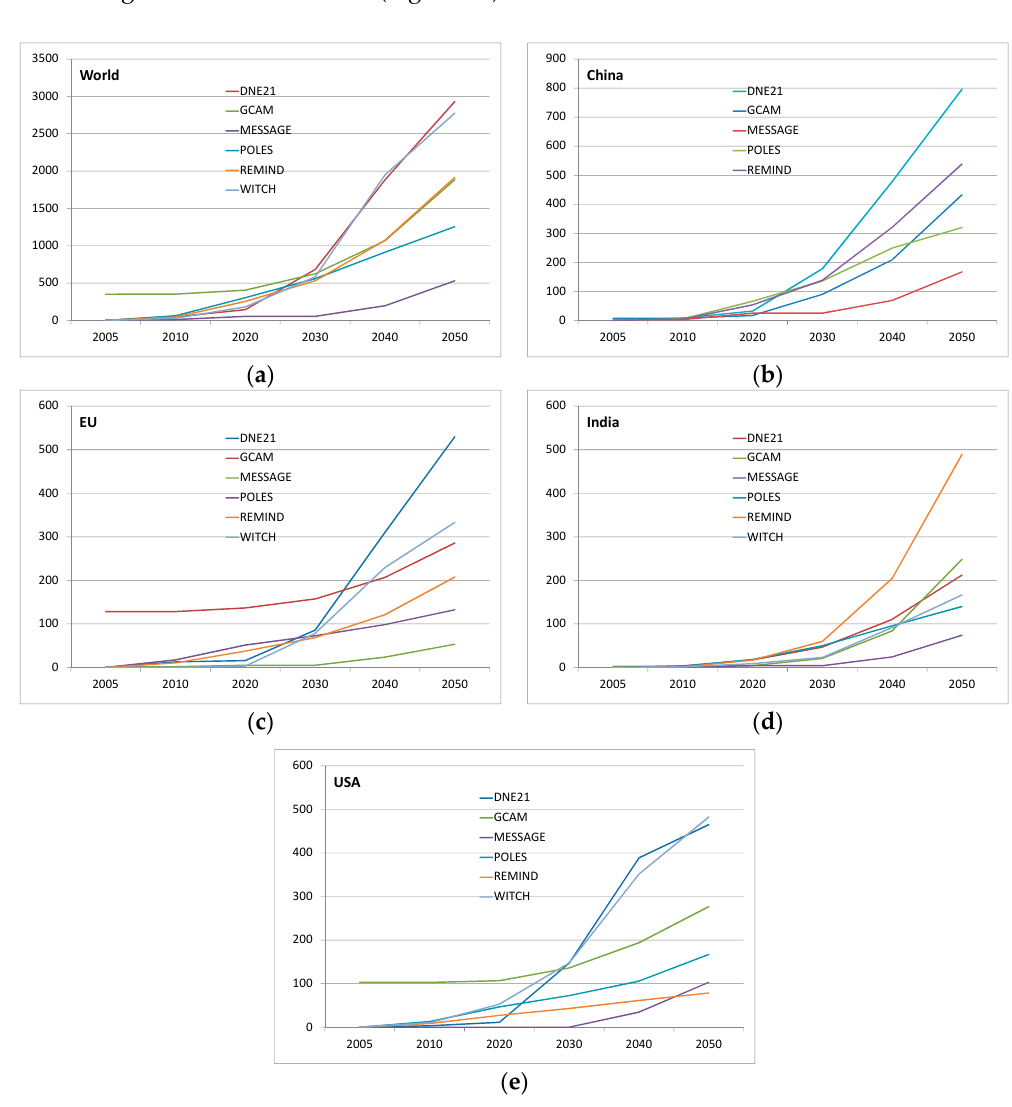
( d ) ( e ) Figure B2. Inter-model comparison of installed capacity (GW) for solar PV in ( a ) World (2030–2050 growth rate = 8%–22% p.a.); ( b ) China (2030–2050 growth rate = 13%–35% p.a.); ( c ) The EU (2030–2050 growth rate = 4%–10% p.a.); ( d ) India (2030–2050 growth rate = 15%–22% p.a.) and ( e ) USA (2030–2050 growth rate = 3%–30% p.a.)